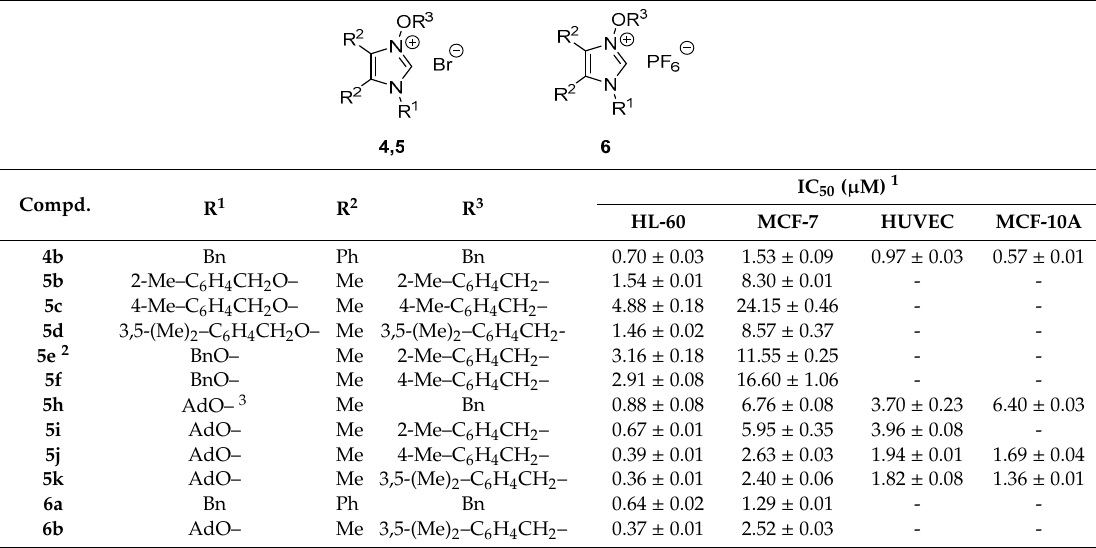
Table 1. In vitro cytotoxic activity of selected alkoxyimidazolium bromides 4 and 5 and hexafluorophosphates 6 tested on two cancer cell lines and two normal cell lines.